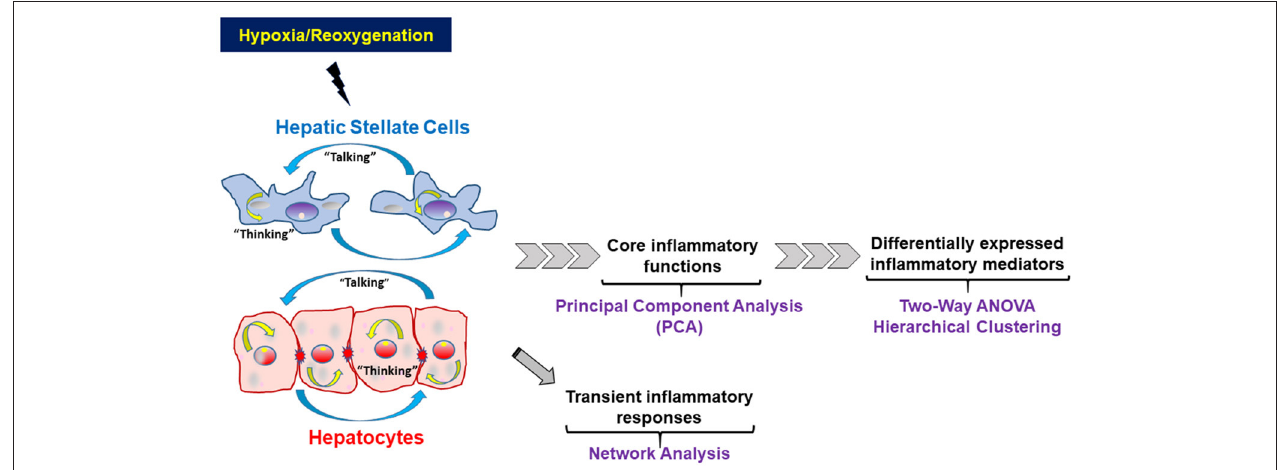
FIGURE 1 | Schematic of the statistical and computational methods and the rationale for their use to study the way liver cells respond to inflammatory stimuli. Hepatocytes and Hepatic Stellate Cells respond to hypoxic stress and reoxygenation by both producing and releasing inflammatory mediators that form defined networks, which can be characterized using network analysis techniques. As the presence of signals and networks persists, early regulatory cytokines begin to be secreted. Some of these core mediators are present at low levels, often with high variance, and their presence and effect may be inferred, as an initial filter, using techniques such as Principal Component Analysis (PCA). At the same time, other inflammatory mediators are usually significantly elevated as defined by standard statistical analyses and thus can be defined as biomarkers of elevated